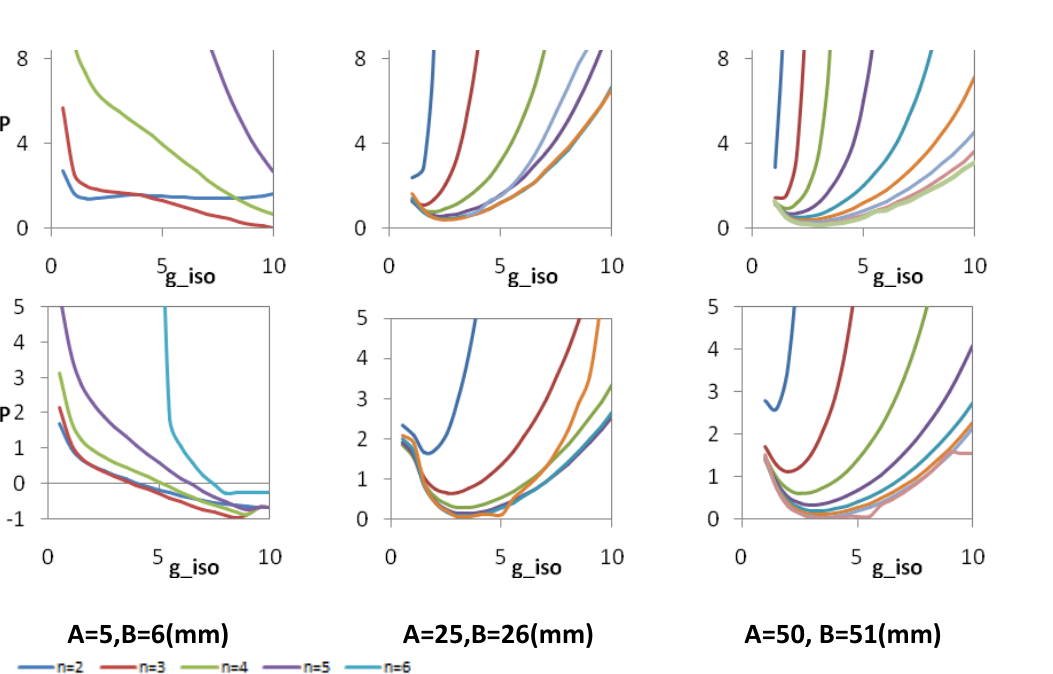
Figure 12: Effect of wound size. B=A+1mm, C=A+45mm(large enough to simulate infinity). (a) Fixed outer boundary simulating stiff skin. Critical buckling radial growth rate vs. wound size. (b) Enforced circular outer boundary simulating loose skin. Radial growth. Critical buck- ling radial growth rate(and buckling mode as the numbers indicate) vs. 𝛾 for various wound sizes. (c) Enforced circular outer boundary sim- ulating loose skin. Isotropic growth. Critical buckling pressure vs. isotropic growth rate. First row: 𝛾 = PI/3; Second row: 𝛾